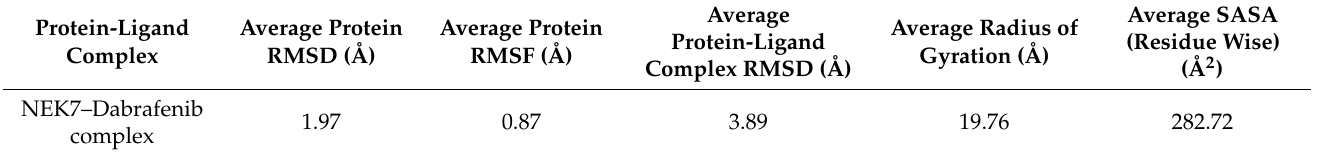
Table 5. Average values obtained from MD